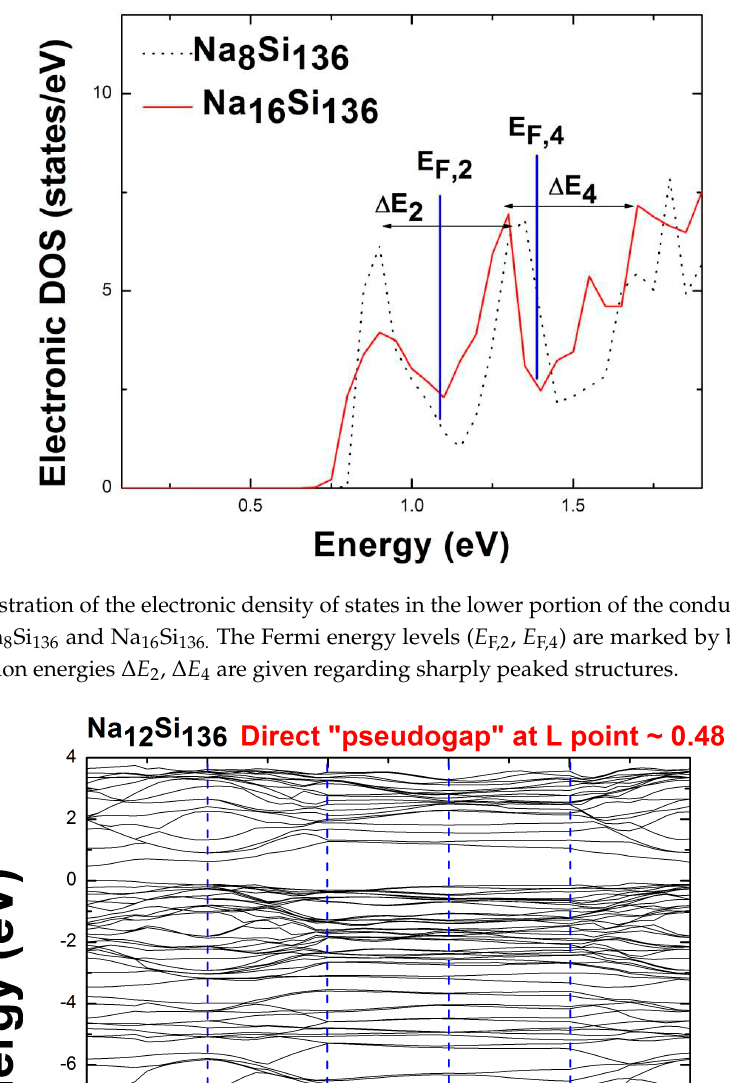
Figure 1. Illustration of the electronic density of states in the lower portion of the conduction band for clathrates Na 8 Si 136 and Na 16 Si 136. The Fermi energy levels ( E F,2 , E F,4 ) are marked by blue lines and quasi- activation energies Δ E 2 , Δ E 4 are given regarding sharply peaked structures.